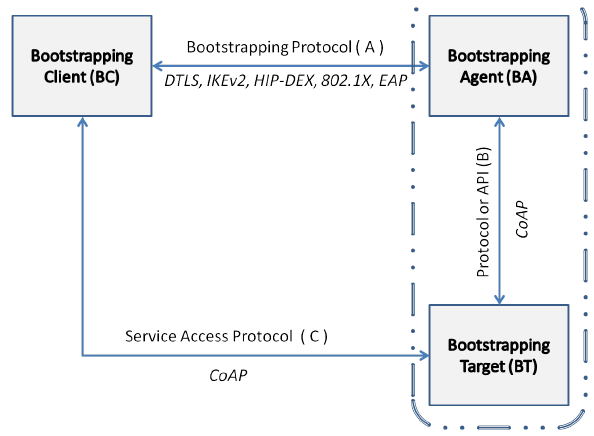
Figure 2. Bootstrapping framework for internet of things